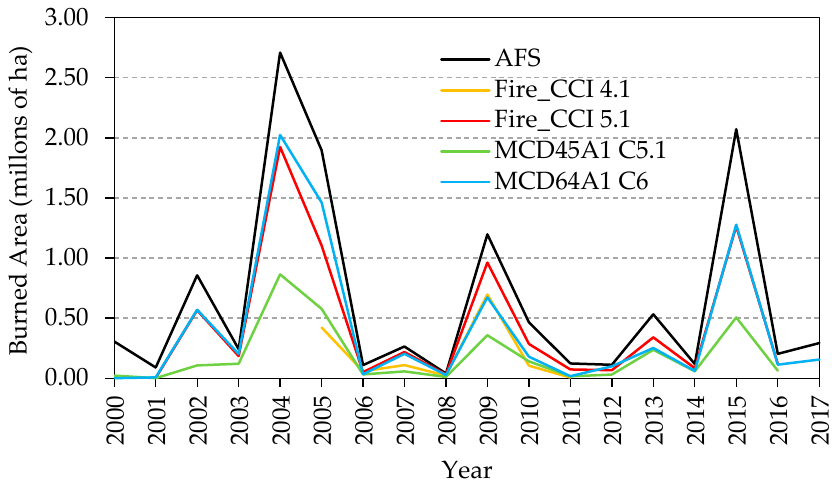
Figure 8. Temporal distribution of the annual burned area estimation for the Fire_CCI 4.1, Fire_CCI 5.1, MCD45A1 C5.1 and MCD64A1 C6 products along with the AFS reference data.